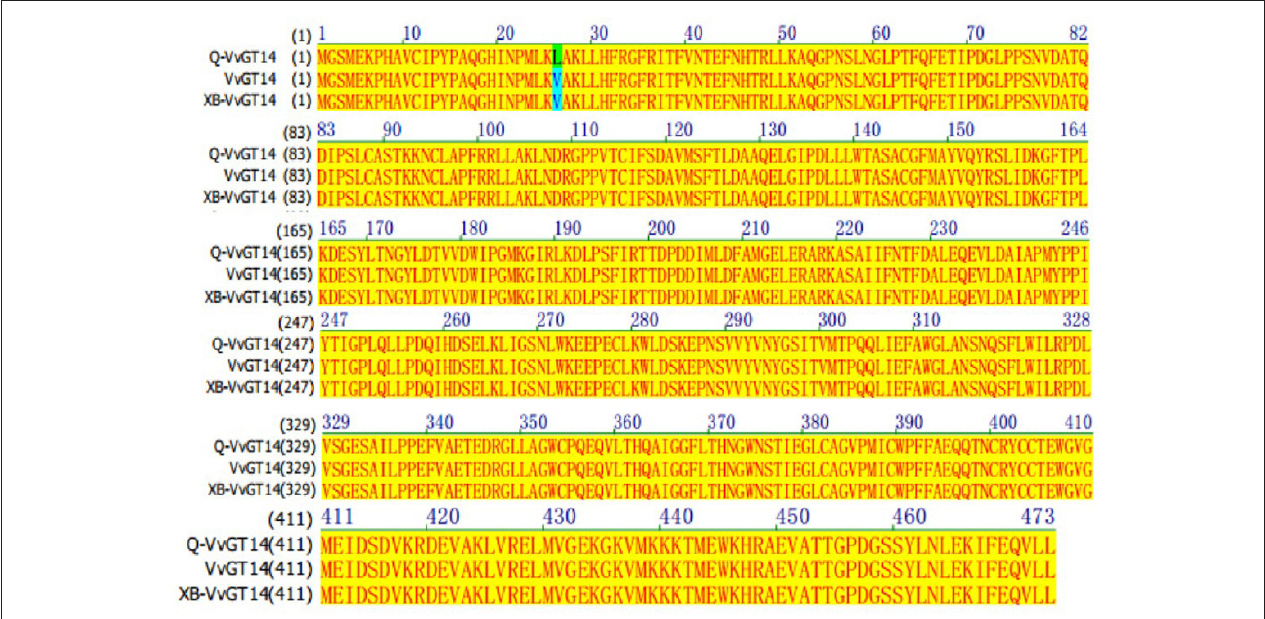
FIGURE 5 | Amino acid sequence alignment of VvGT14 in “Gewürztraminer” and “Muscat blanc à Petit grain” for grape berries. Q-VvGT14 represents the VvGT14 sequence of “Gewürztraminer” grapes; XB-VvGT14 represents the VvGT14 sequence from “Muscat blanc à Petit grain” grapes, VvGT14 represents the sequence from “Pinot noir” grapes published in